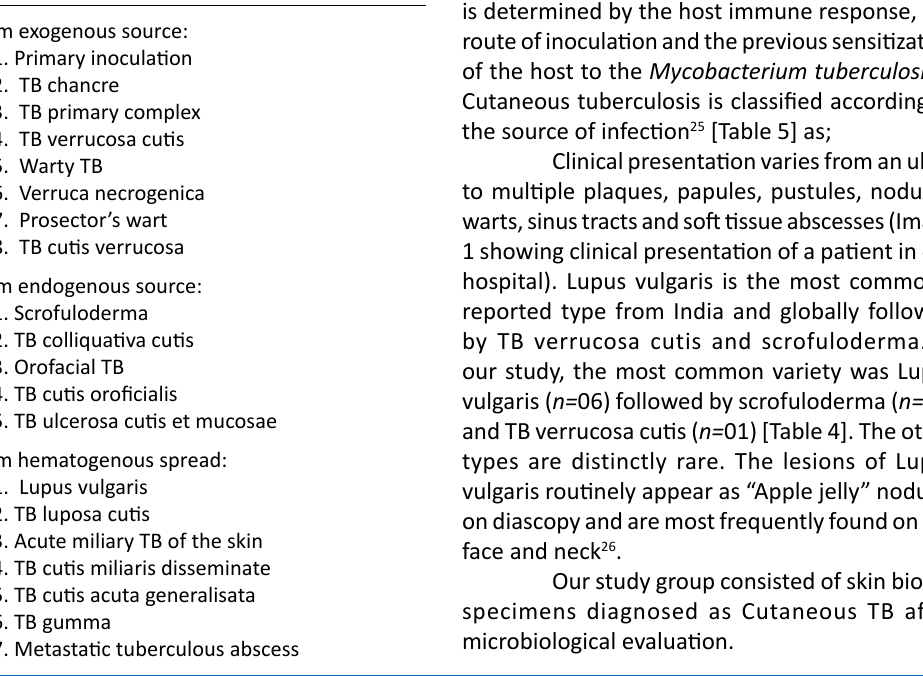
Table 5. Classification of cutaneous TB (According to the source of